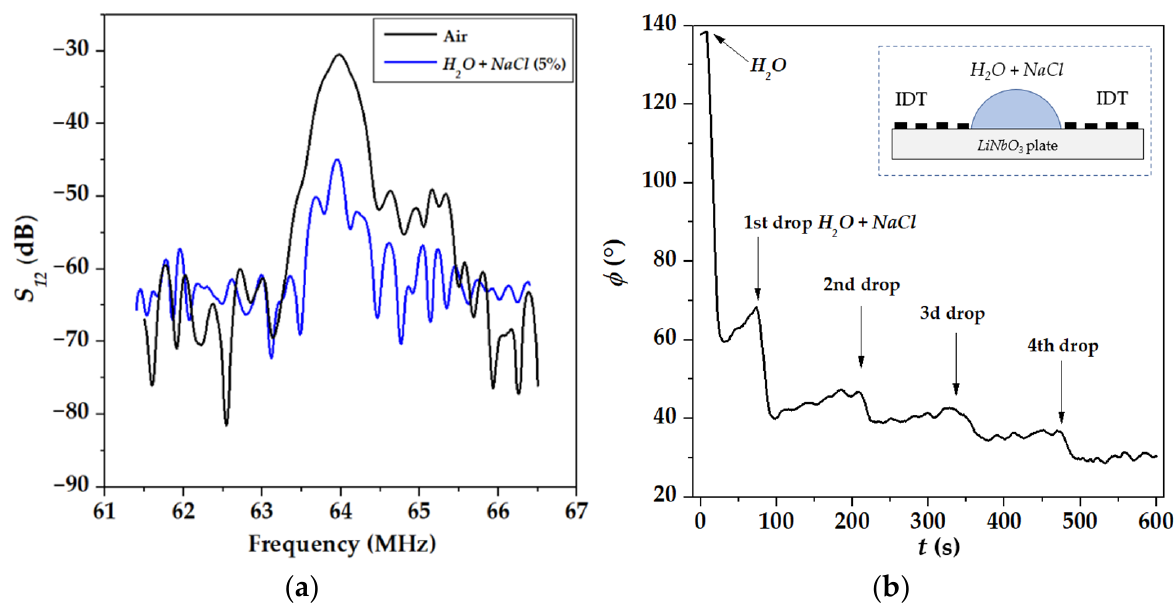
Figure 4. Insertion loss S 12 ( a ) and phase ϕ ( b ) measured for AIR (without liquid) and conductive liquids ( H 2 O + NaCl (5%)) with σ from 0 to 6 S/m deposited over the whole propagation path (30 mm). Plate: 128°YX- LiNbO 3 , h = 500 μm. Mode f = 63.9 MHz, λ = 200 μm. Test liquids: distilled water H 2 O